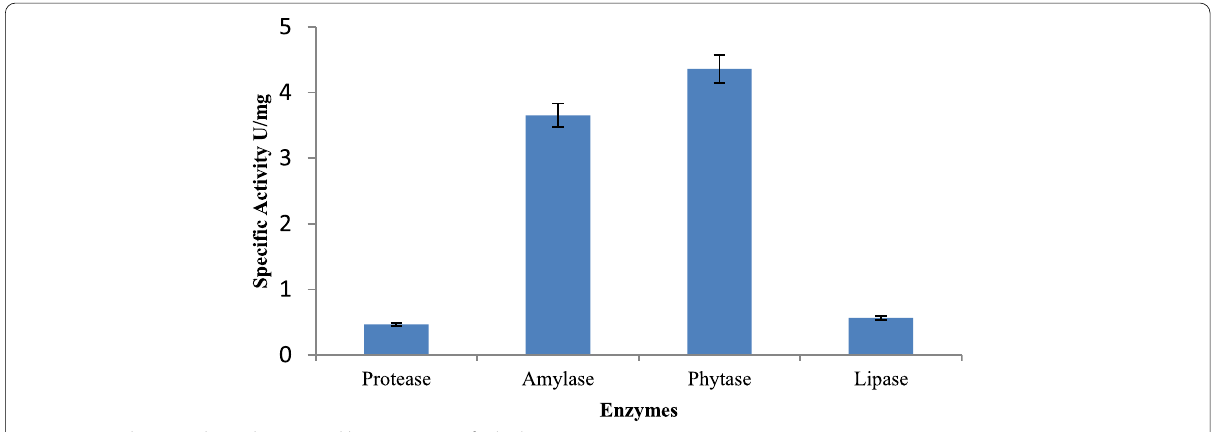
Fig. 3 Proteolytic, amylase, phytase, and lipase activity of P. kudriavzevii